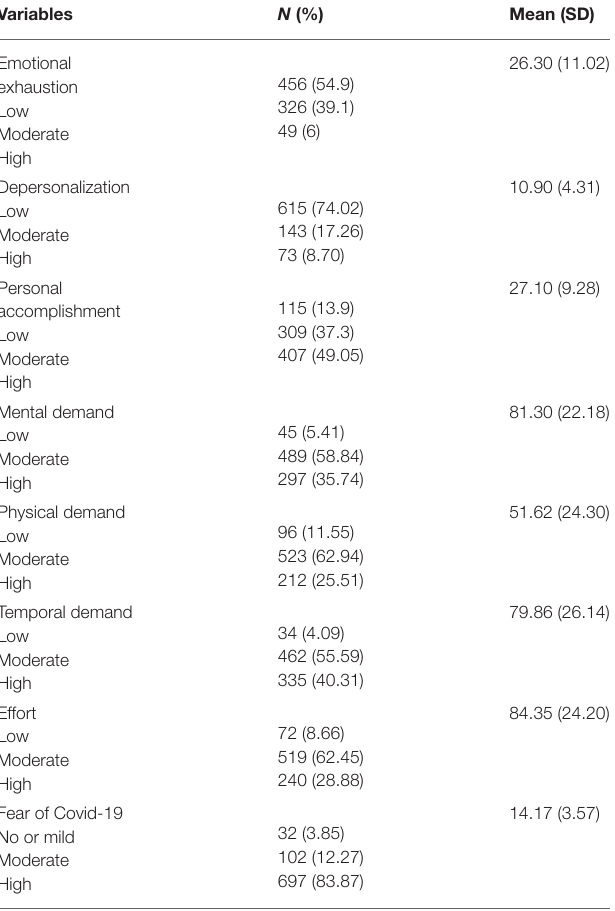
TABLE 2 | Burnout symptoms and task load items and fear felt by nurses during work under COVID-19 at studied teaching hospitals ( n = 831).